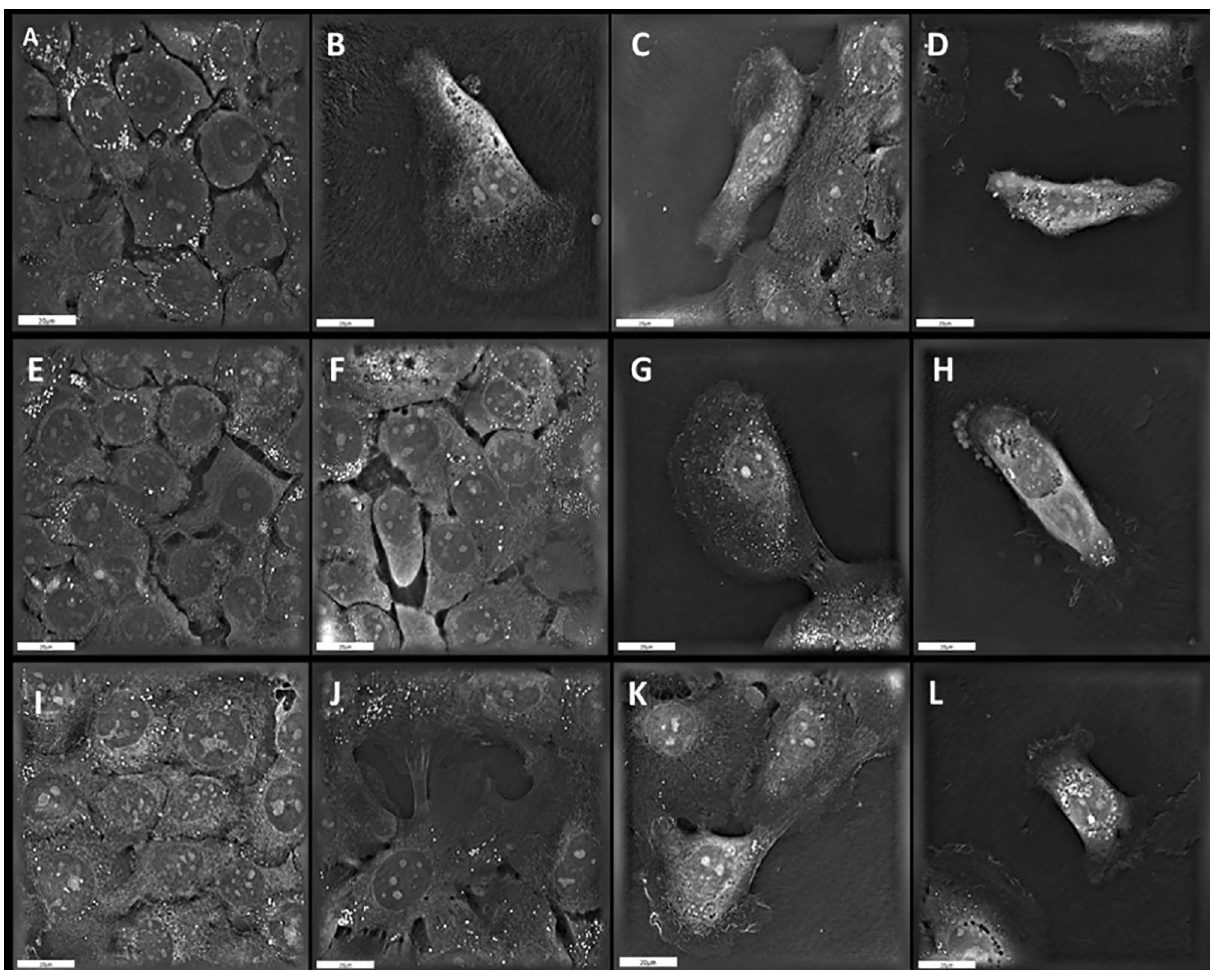
Figure 1. Holotomographic microscopy scoring example of EMT characteristics (SCC25). ( A ) Score 0 for fibroblast-like-morphology (FM). ( B ) Score 1 for FM. ( C ) Score 2 for FM and ( D ) score 3 for FM. ( E ) Score 0 for cell individualization. ( F ) Score 1 for cell individualization. ( G ) Score 2 for cell individualization and ( H ) score 3 for cell individualization. ( I ) Score 0 for surface adhesion, ( J ) Score 1 for surface adhesion. ( K ) Score 2 for surface adhesion and ( L ) Score 3 for surface adhesion. Live cell imager (Nanolive, Switzerland); 20 Cell line heterogeneity. Consistent with the heterogeneity of head and neck cancer, the four HNSCC cell lines used differed markedly in all parameters investigated (Fig. 2A–C, control). The baseline expression of SNAI2 differed by up to fivefold among the four cell lines (p < 0.001; Fig. 2A) SCC25 cells had a baseline relative SNAI2 expression of 17.7 ± 2.2, and CAL 27 cells had a baseline relative expression of 3.5 ± 0.4. Marked differ- ences between cell lines were also observed for baseline vimentin expression (p < 0.001). Again, SCC25 cells had the highest expression at 4.7 ± 1.1, and CAL 27 cells had the lowest expression at 2.2 ± 0.5 × 10 –3 (Fig. 2B). Flow